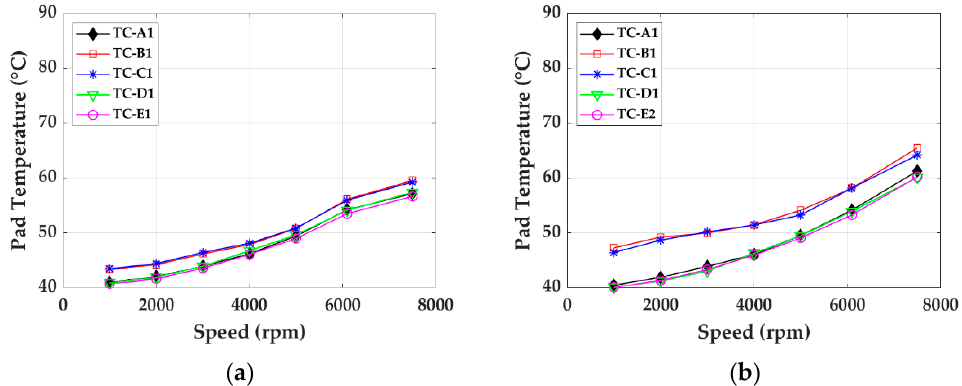
Figure 17. Direct Lube Rocker Pivot bearing pad temperatures @ 25% of pad arc: ( a ) 0.8 MPa, ( b ) 1.7 MPa.